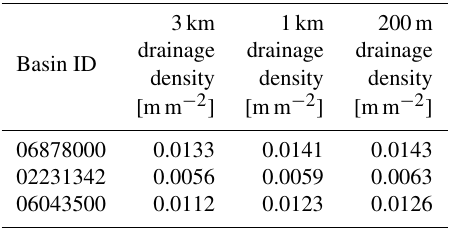
Table 4. The drainage density defined as total river length divided by basin area for the three example